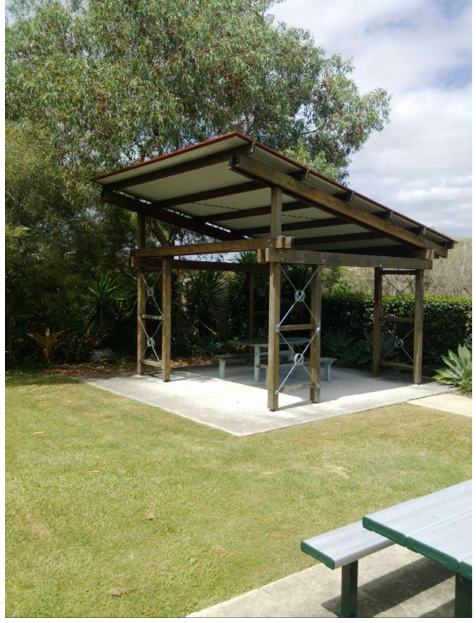
Figure 4. Urine stench.